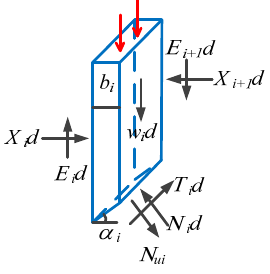
Figure 11. Force diagram of soil strip i.